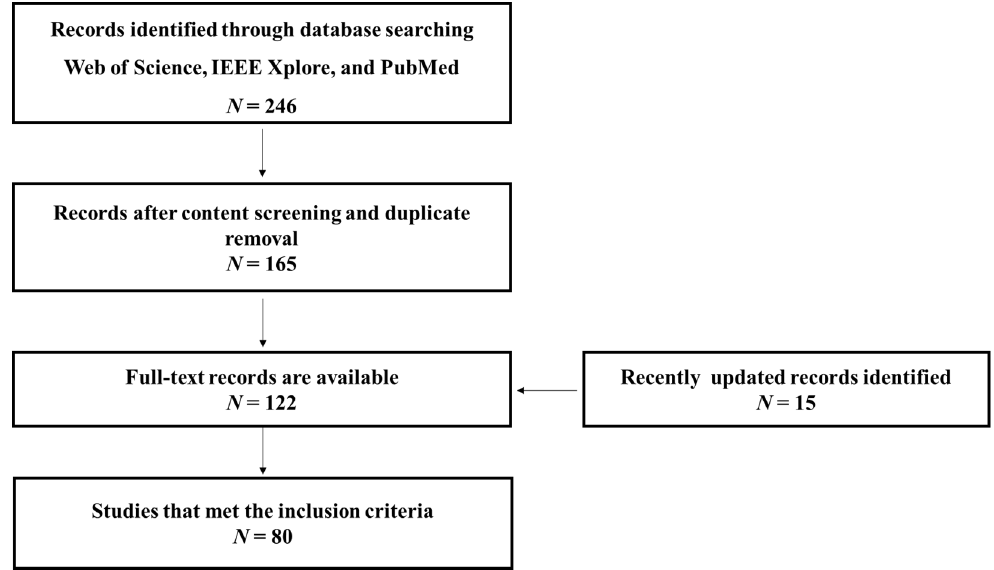
Figure 2. The search method for identifying relevant studies.